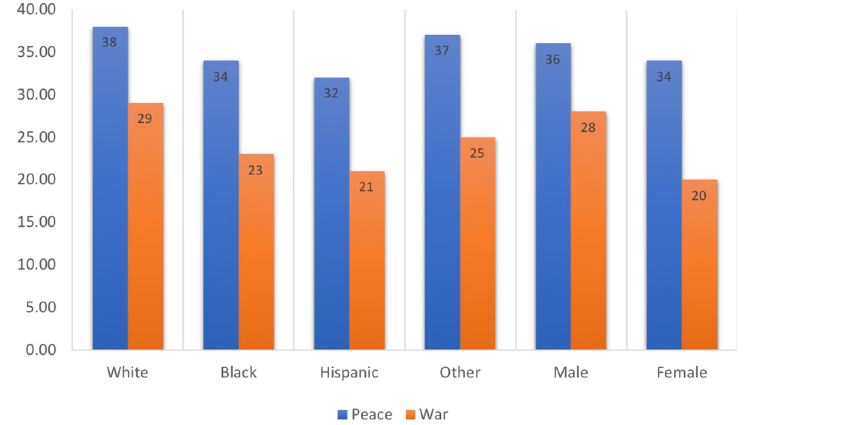
Fig 2. Promotion rates (%) by racial-ethnic groups and sex during peace and